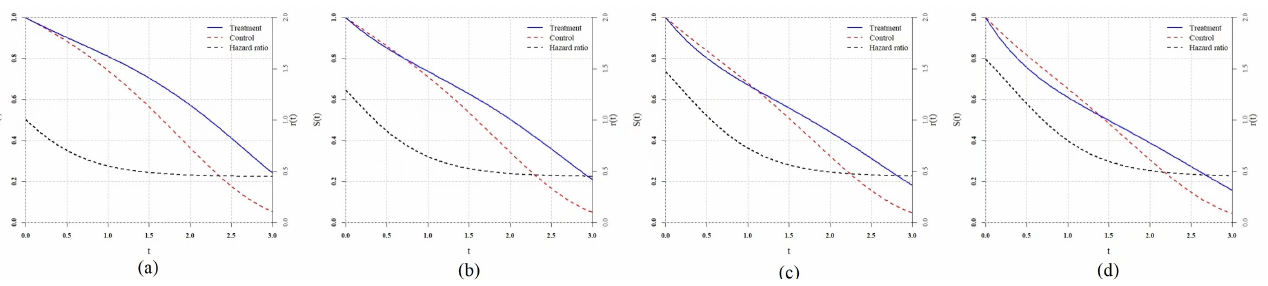
Figure 2. Survival curves with CH function family with parameter settings: γ = 0.1, θ C = − 0.4, θ T = 0.4 ( a ) ρ = 1 ( b ) ρ = 2 ( c ) ρ = 3 ( d ) ρ = 4.